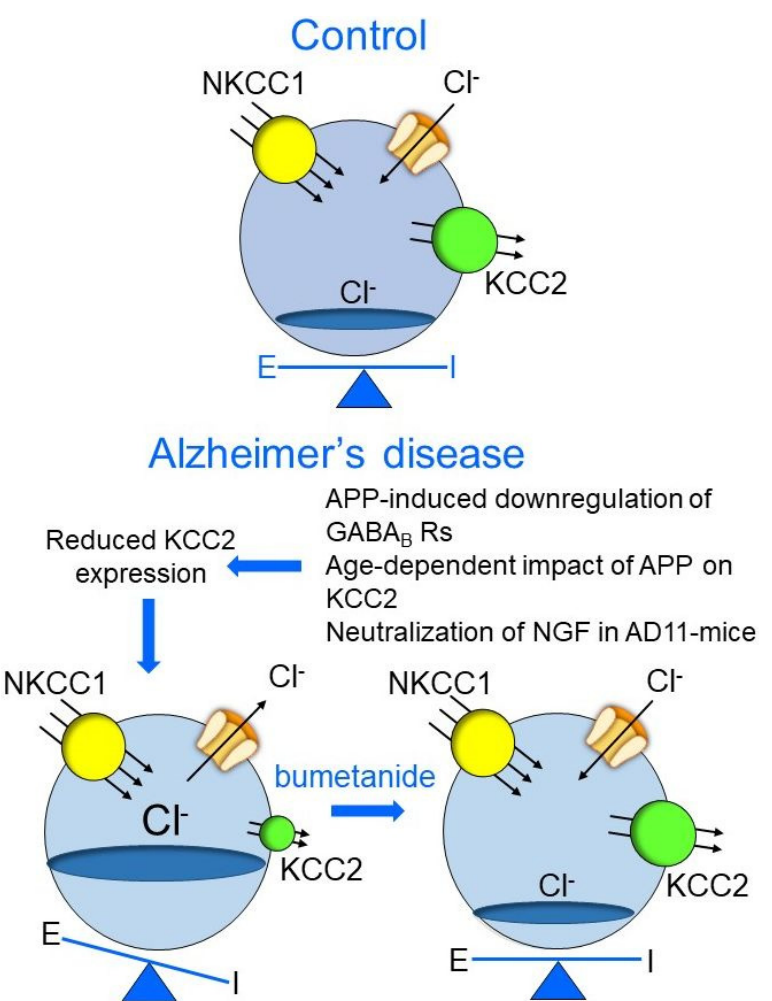
Figure 1. Altered chloride homeostasis in AD. In the adult brain ( top ), the intracellular levels of chloride, are maintained at very low levels by the cation-chloride importer and exporter NKCC1 and KCC2, respectively. GABA binds to its receptor and opens the channel, giving rise to an inward flux of chloride, which inhibits targeted cells by hyperpolarizing the membrane. In this way, it contributes to preserve the appropriate E/I balance in selective neuronal circuits. In AD, the APP-induced downregulation of GABA B Rs, the age-dependent impact of APP on KCC2, or neutralization of NGF in AD11 mice allows GABA to shift from the hyperpolarizing to the depolarizing direction, as in immature neurons, giving rise to an outwardly directed flux of chloride and E/I imbalance with consequent enhancement of network excitability ( down left ), which is an effect that can be rescued by blocking NKCC1 with bumetanide ( down right ).